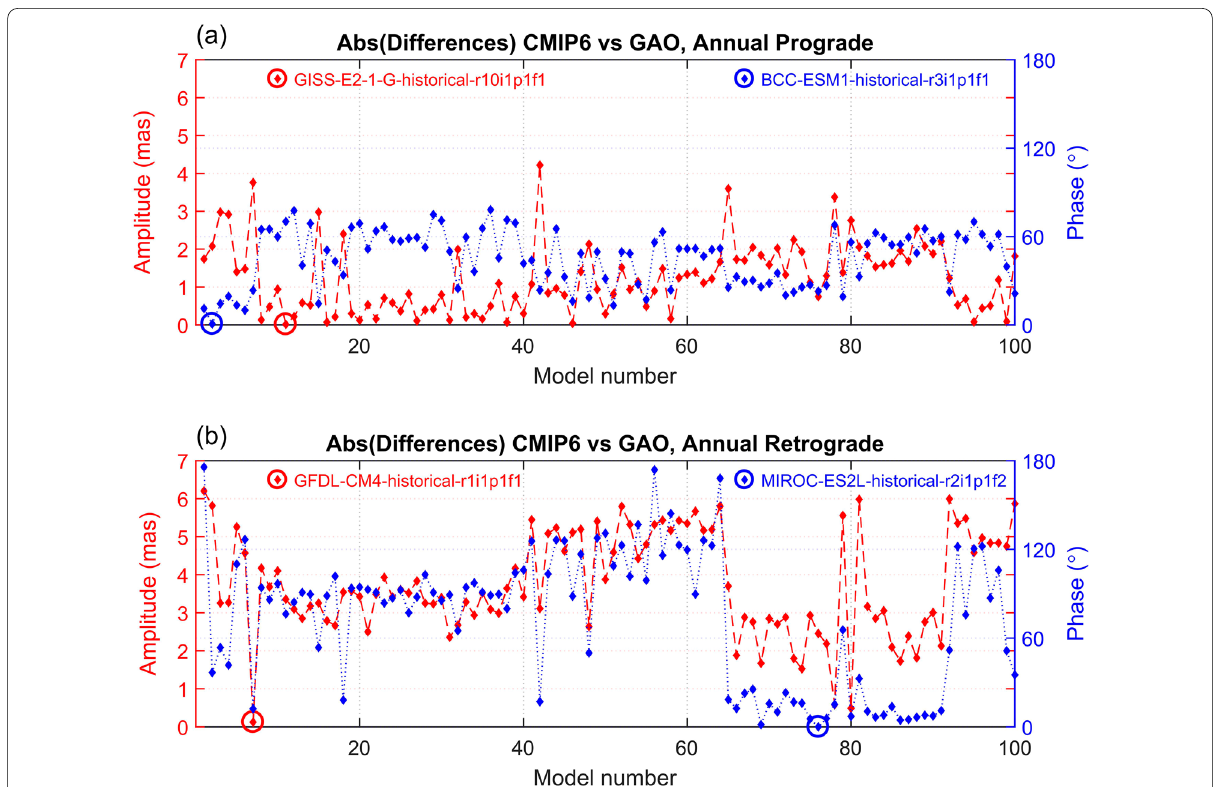
Fig. 6 Absolute values of differences in amplitudes and phases between CMIP6-based HAM and GAO for a annual prograde oscillation and b annual retrograde oscillation. The models for which the amplitude and phase differences are the smallest are indicated by circles and labels